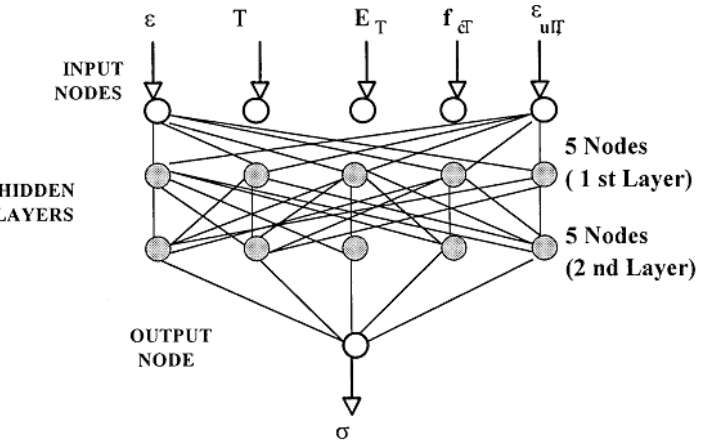
Figure 1. The structure of a feedforward network. Adapted with permission from ref. [32]. Copyright 1997 Open Access & Nature Research.